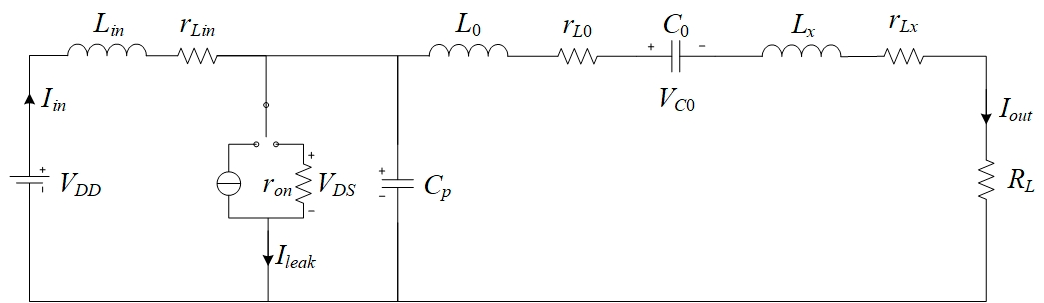
Figure 2. Class-E model under non-ideal condition.